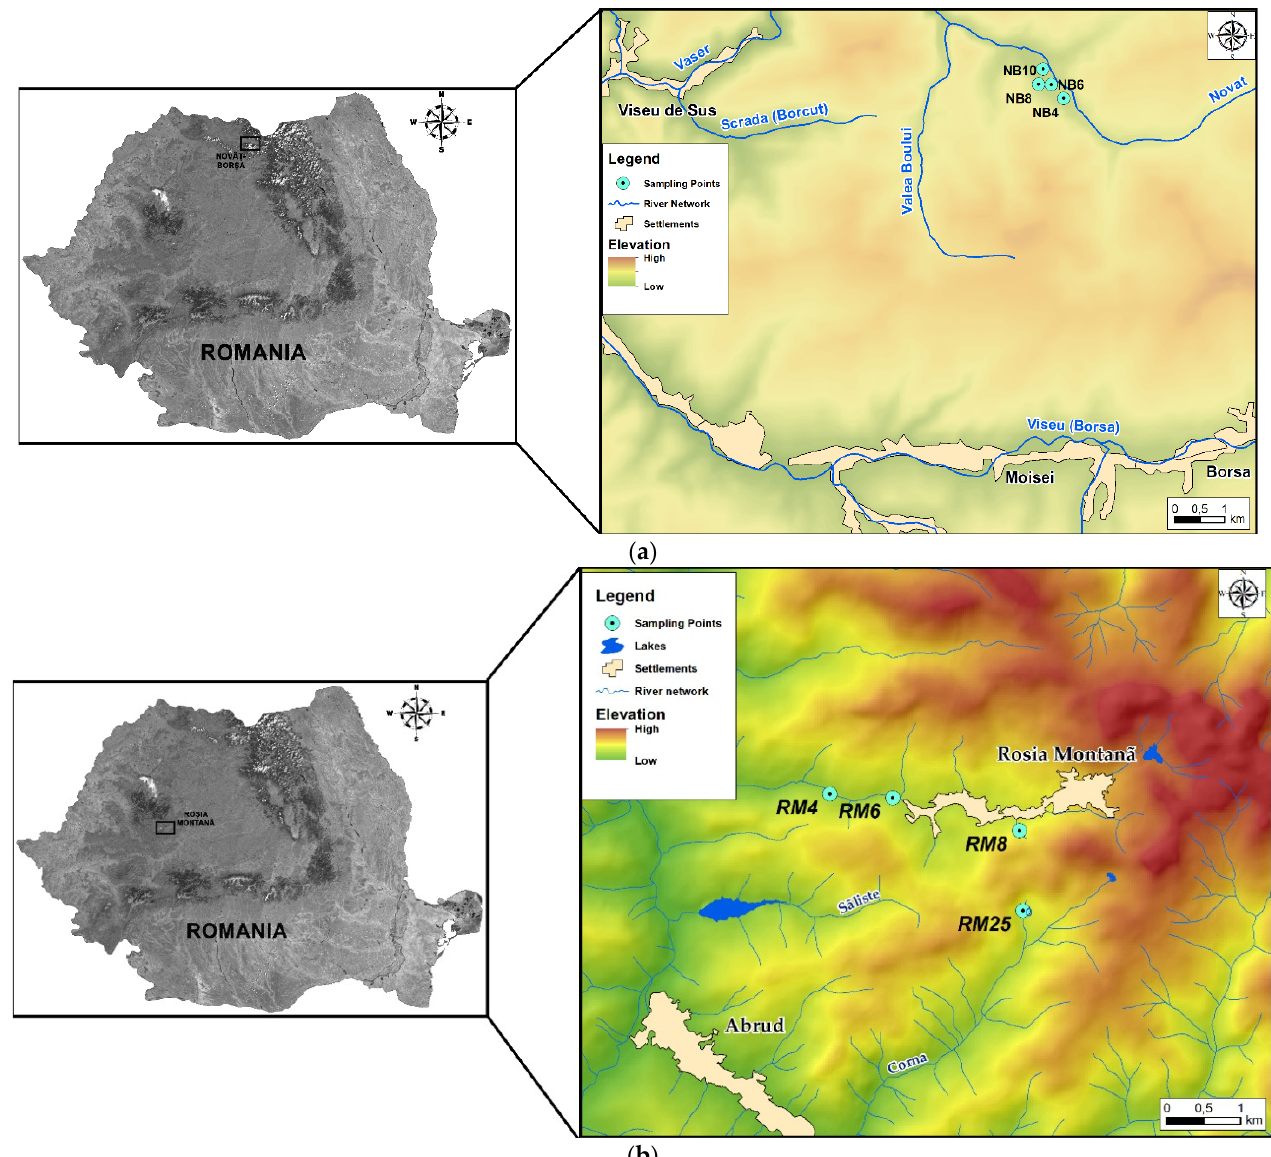
Figure 1. Map of the collected water samples: ( a ) Nov ăț -Bor ș a mining area, ( b ) Ro ș ia Montan ă mining area.